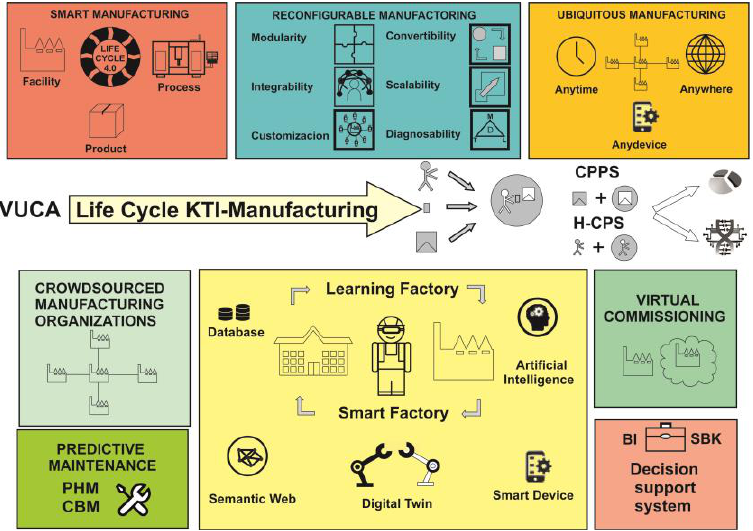
Figure 2. Application context for DfHFinI4.0.